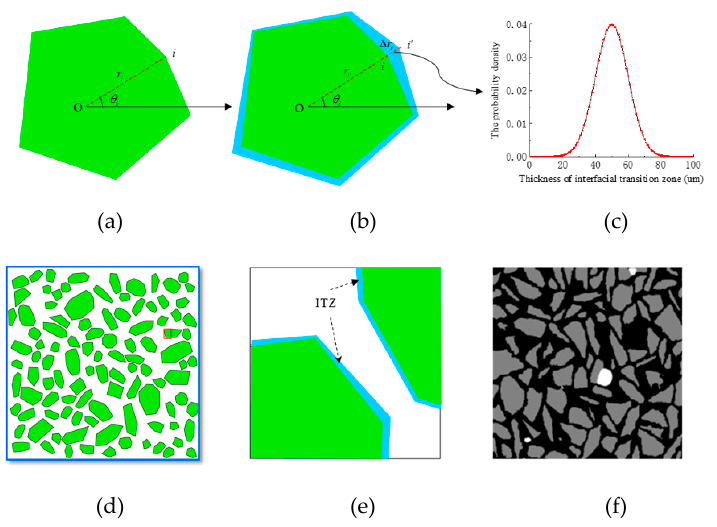
Figure 1. Concrete mesoscopic model generation. ( a ) A single aggregate, ( b ) Generate ITZ, ( c ) ITZ thickness probability distribution, ( d ) mesoscopic aggregate model, ( e ) Local magnification, ( f ) CT scanning of concrete [7],